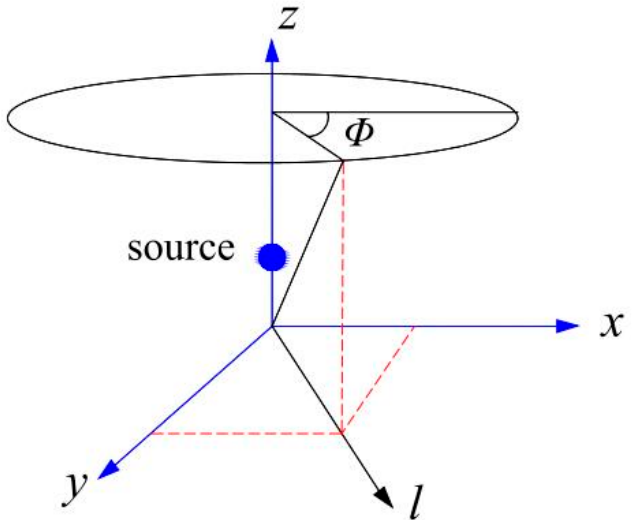
Figure 2. Rectangular x-y-z coordinates and cylindrical l-ø-z coordinates.